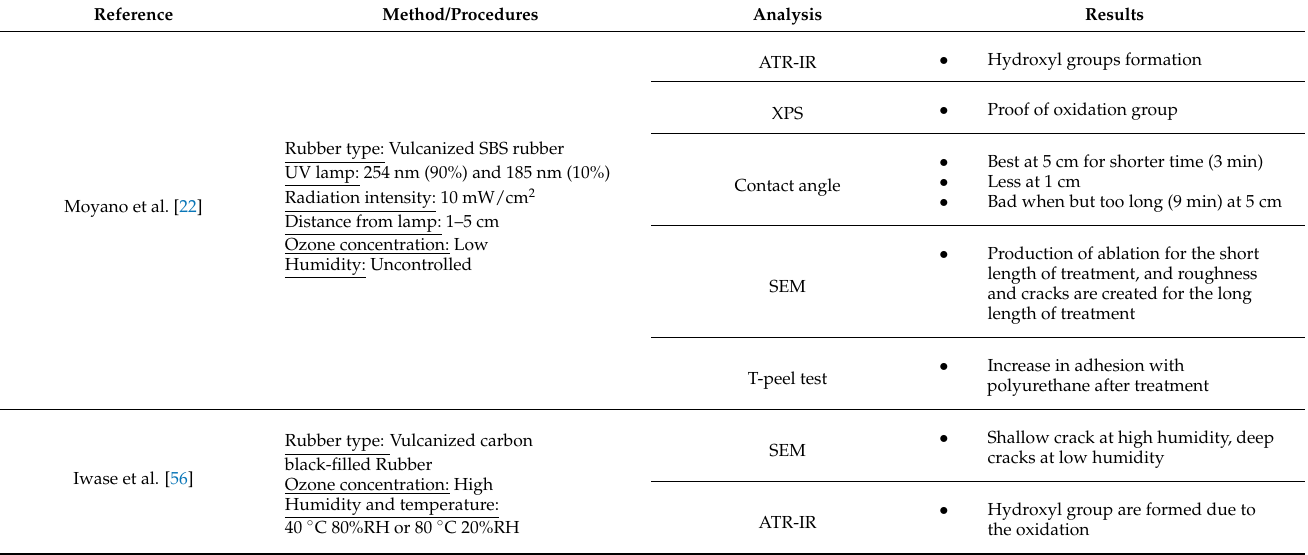
Table 2. Summary of the studies on the procedures and results using UV-ozone